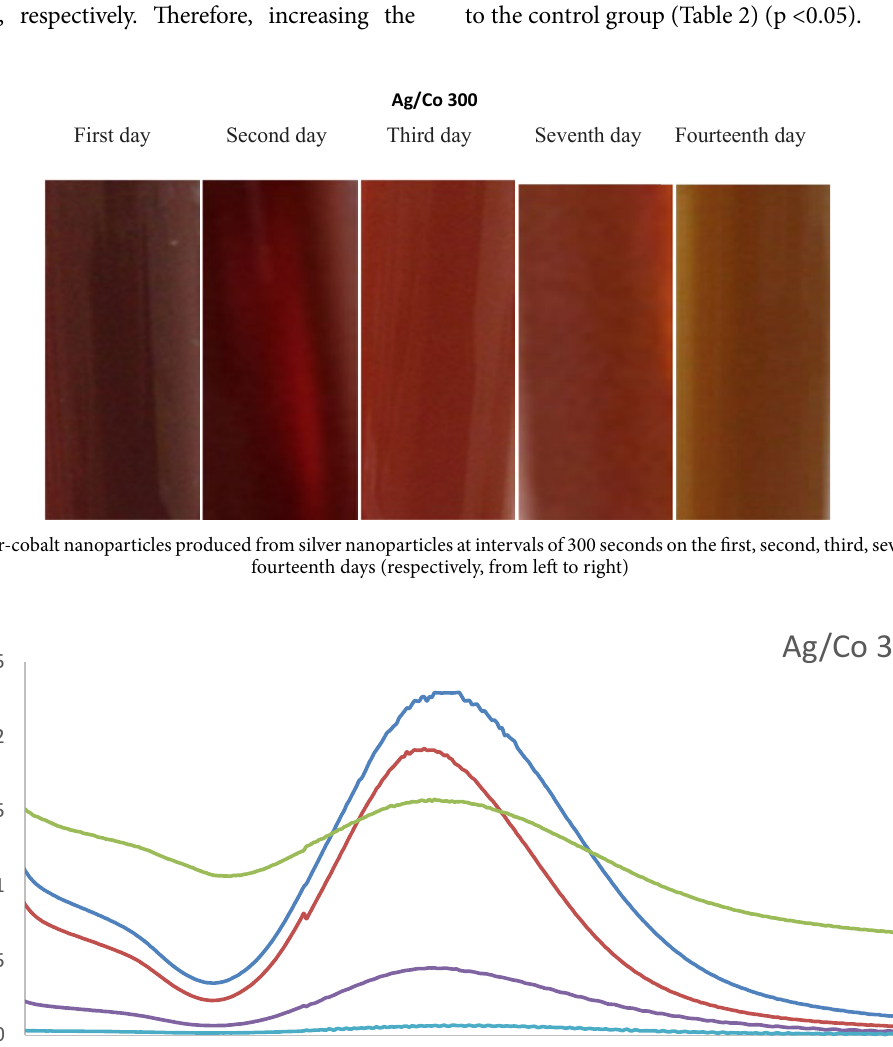
240 Nanomed Res J 3(3): 236-244, Autumn 2018